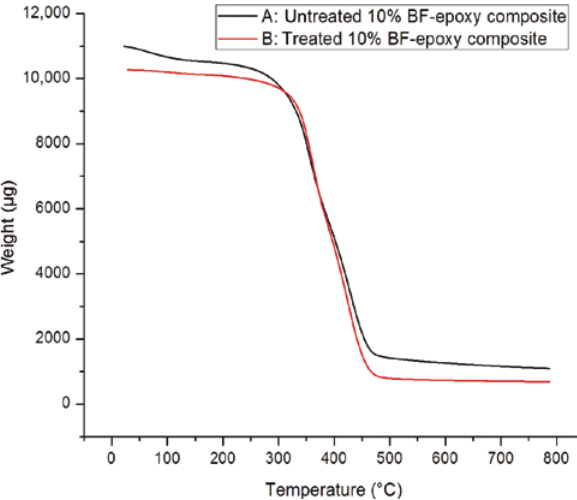
Figure 2: TGA thermogram of untreated and treated 10% BF-epoxy composites.